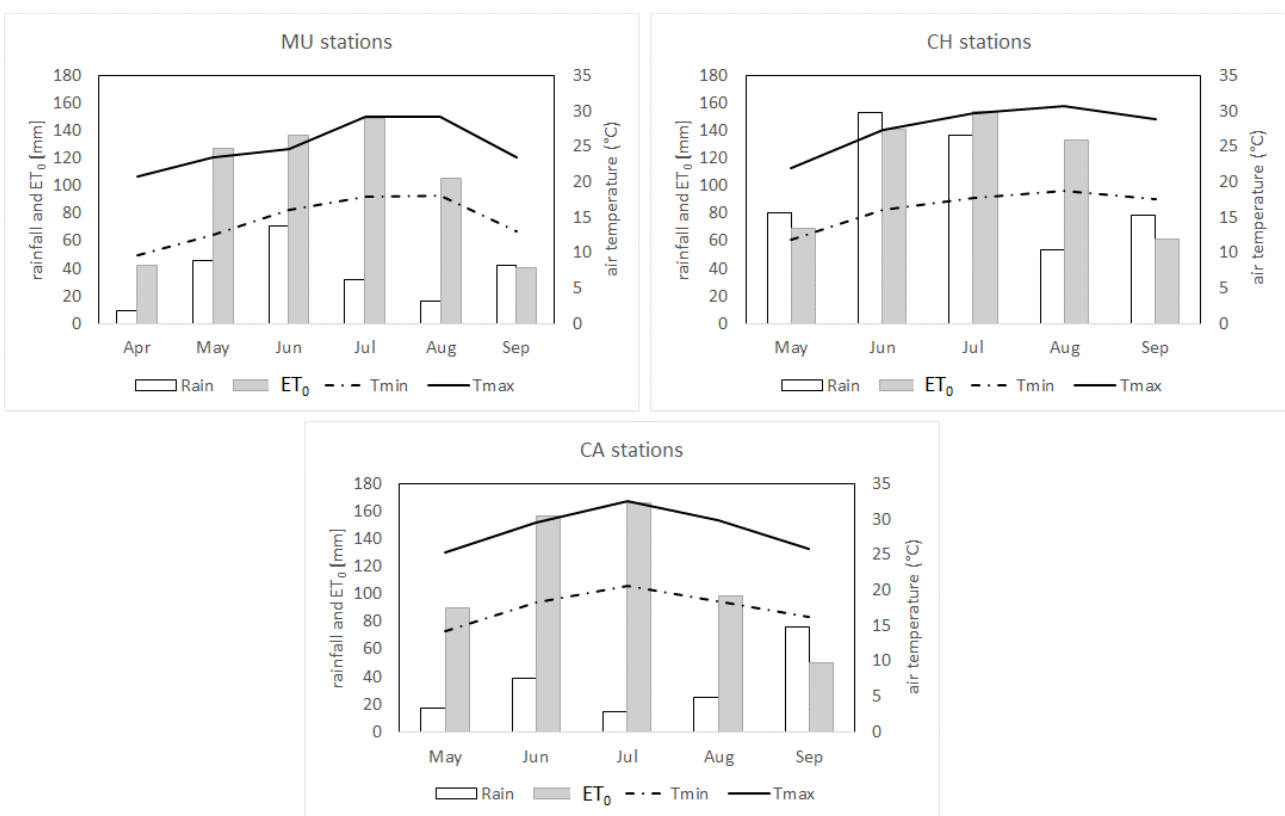
Figure 2. Averages of monthly values for the main climatic parameters at the three sites over the analyzed years. For rain and ET 0 , the monthly total amounts are shown, while for minimum and maximum air temperature, monthly averages are shown. Table 1. Case studies fields, with soil type, planting/sowing and harvesting dates, crop type.